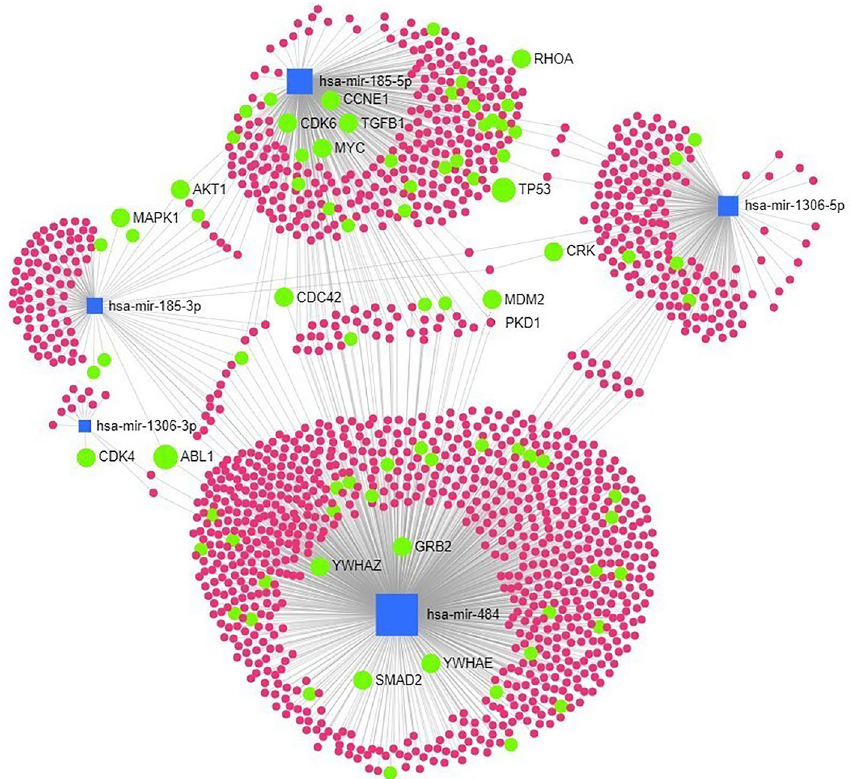
Figure 2. miRNA-gene interaction network of miRNAs most frequently affected by rare CNVs in CAKUT. Only interactions occurring in the kidney tissue have been included in the algorithm. Square shapes represent miRNAs while circles represent genes regulated by specific miRNAs. The size of the squares depicts the number of miRNA-gene interactions based on the miRTarBase v8.0 data. Green circles represent genes included in the significantly enriched pathways (Table 3) whereby the size of the circle is proportional to the number of significantly enriched pathways in which the specific gene